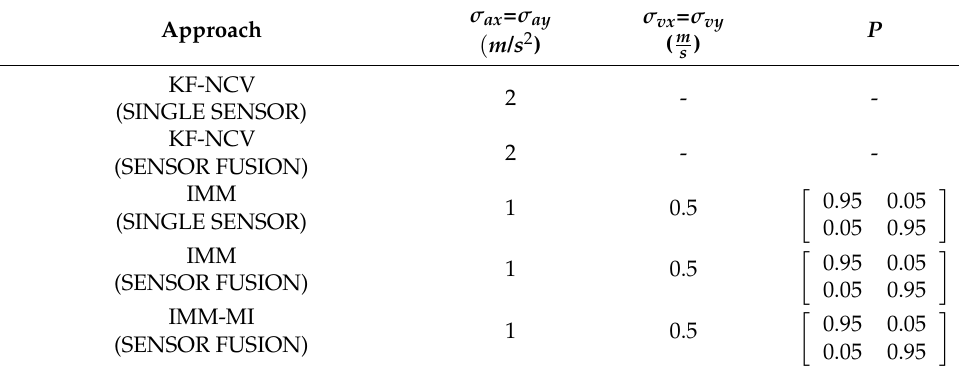
Table 3. Settings of the employed